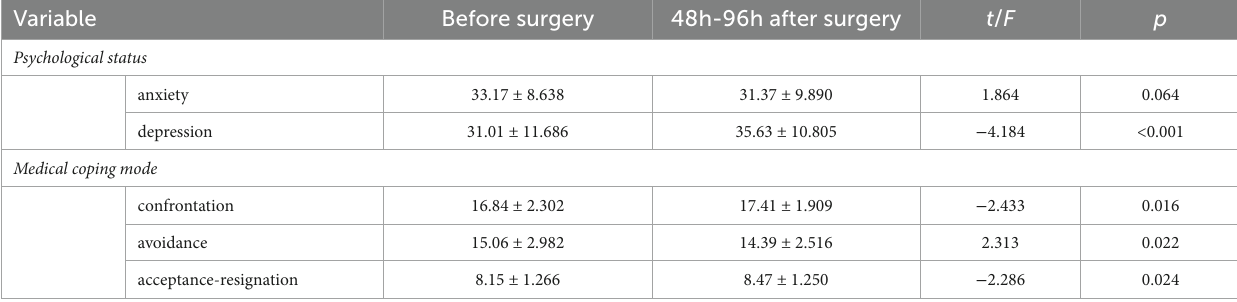
TABLE 2 Comparison of psychological status, medical coping mode and quality of life of lung cancer patients before and after surgery.